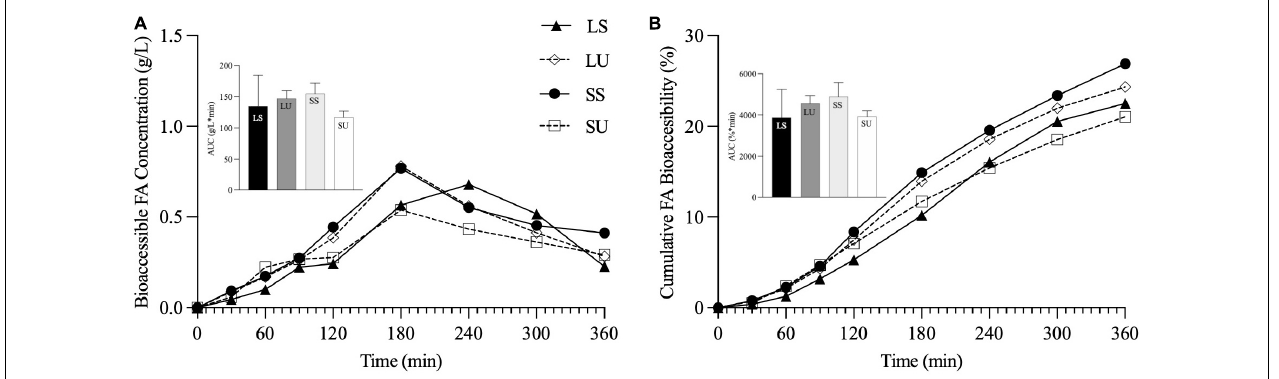
FIGURE 9 | Line graphs representing bioaccessible FA concentration (g/L) (A) and cumulative FA bioaccessibility (%) (B) over time, and inset bar graphs representing AUC of LS, LU, SS, and SU during 6-h in vitro TIM-1 digestion with modified gastric emptying half time for LS ( n ≥ 3). Data reported as mean ± SEM. LS, liquid lipid-acid stable emulsifier; LU, liquid lipid-acid unstable emulsifier; SS, solid lipid-acid stable emulsifier; SU, solid lipid-acid unstable emulsifier; TAG, triacylglycerol; FA, fatty acid; AUC, area under the curve.